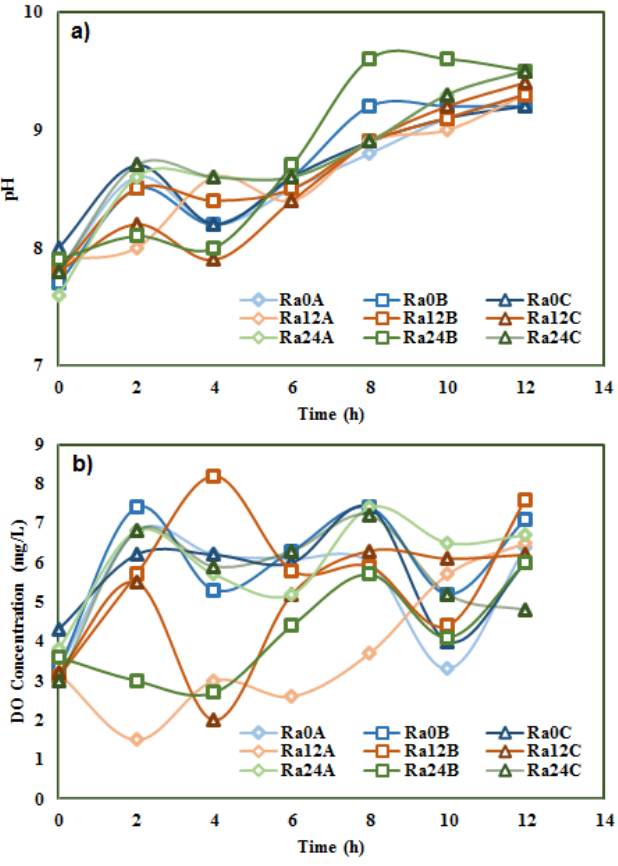
Figure 6. Results of measurements of pH (a) and DO (b) values at each